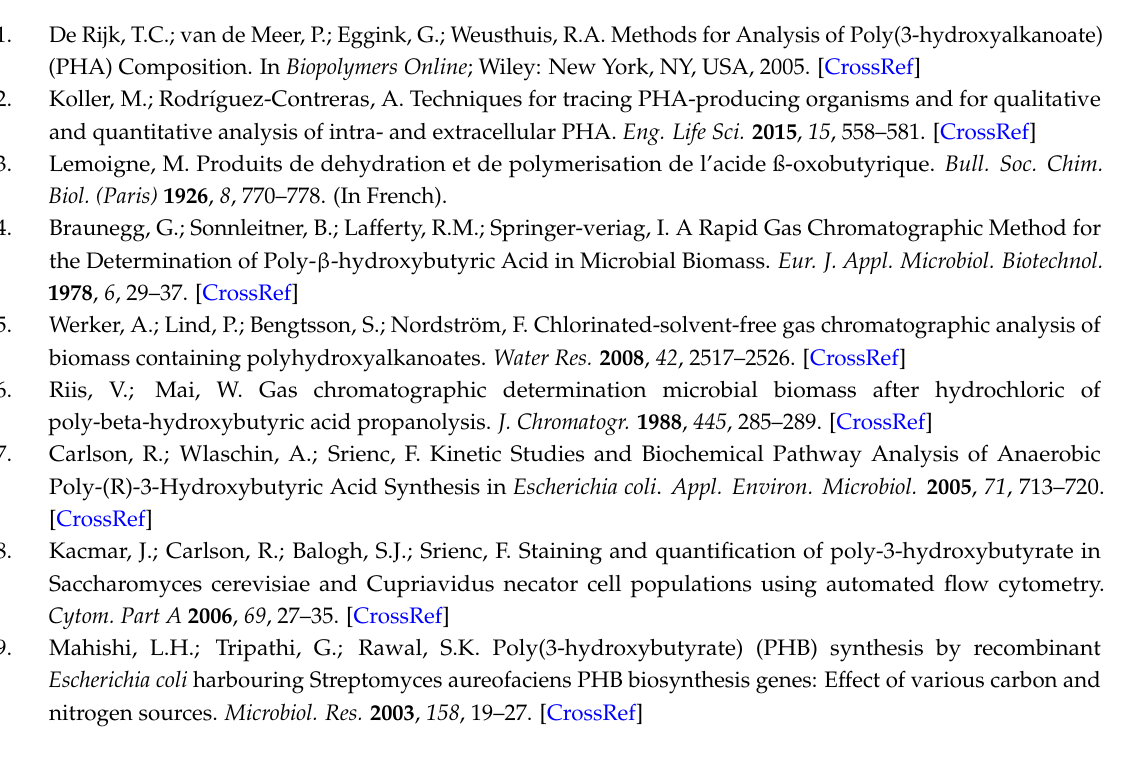
Figure S1: Chemical structure of derivatized 3-HB and observed fragments, Figure S2: Observed standard deviation as a function of the measured average ratio in log scale. Based on the observed linearity, a heteroscedastic error model was assumed, Figure S3: Measured 12 C/BA ratio and linear regression line. Both standard concentration and measured ratio are in log scale, Figure S4: Measured 12 C/PAA ratio and linear regression line. Both standard concentration and measured ratio are in log scale, Table S1: Preparation of a standard calibration (external) using the following standard concentrations, Table S2: Preparation of a standard calibration (external) using the following standard concentrations, Table S3: Measurement of the (PHB) 1 concentration from the two different cultivations, each sample was measured in triplicate, Table S4: Comparison of concentration of (PHB) 1 in different derivatization times, Table S5: Comparison of concentration (PHB) 1 obtained with and without vortexing, Table S6: Comparison of biomass determination in g/L through freeze drying and